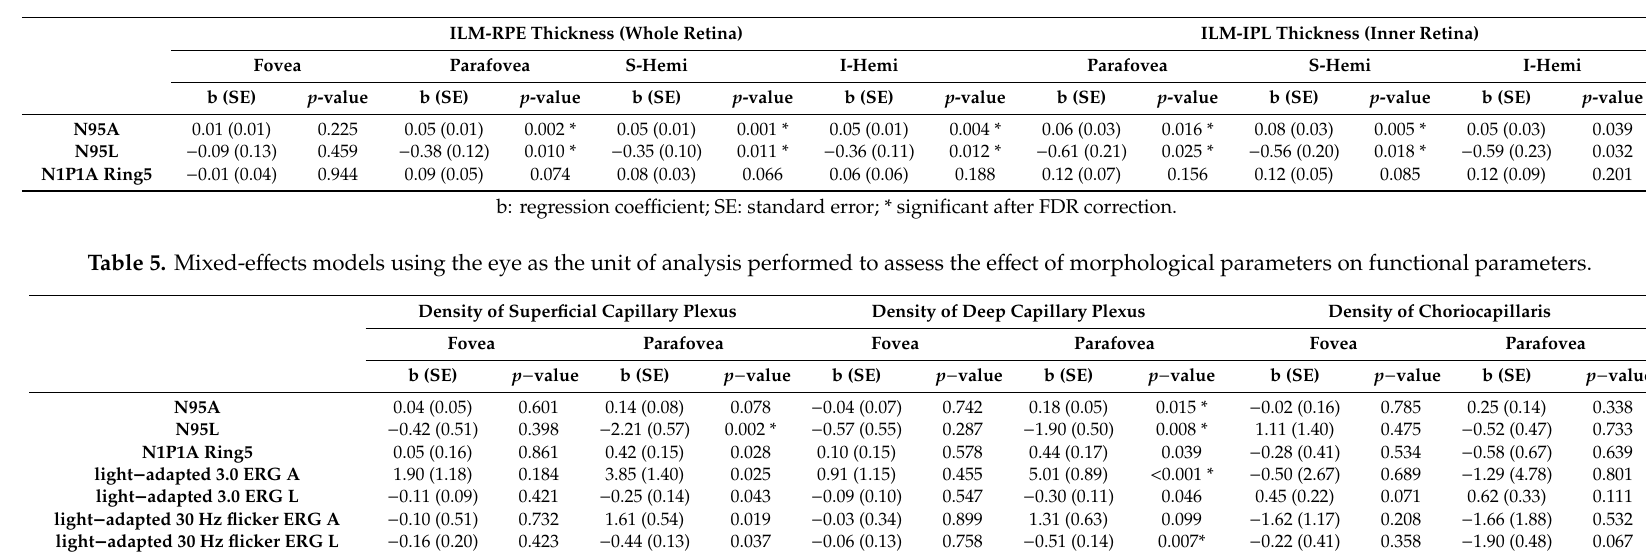
Table 4. Mixed-e ff ects models using the eye as the unit of analysis performed to assess the e ff ect of morphological parameters on functional parameters.